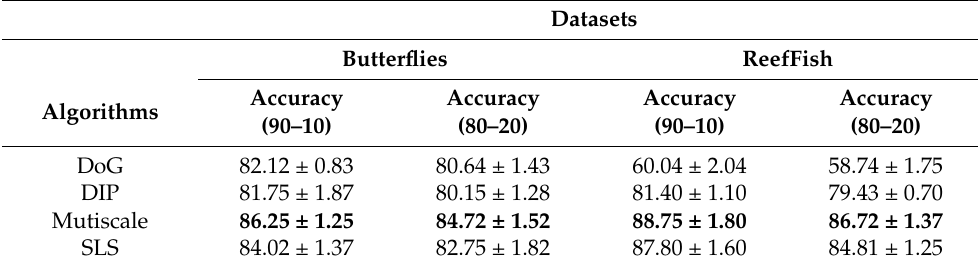
Table 2. Classification accuracies achieved by various traditional schemes with a train–test split of 90–10% and 80–20% on butterflies and ReefFish datasets. The results are also provided with standard deviation, and the best results are highlighted in bold.